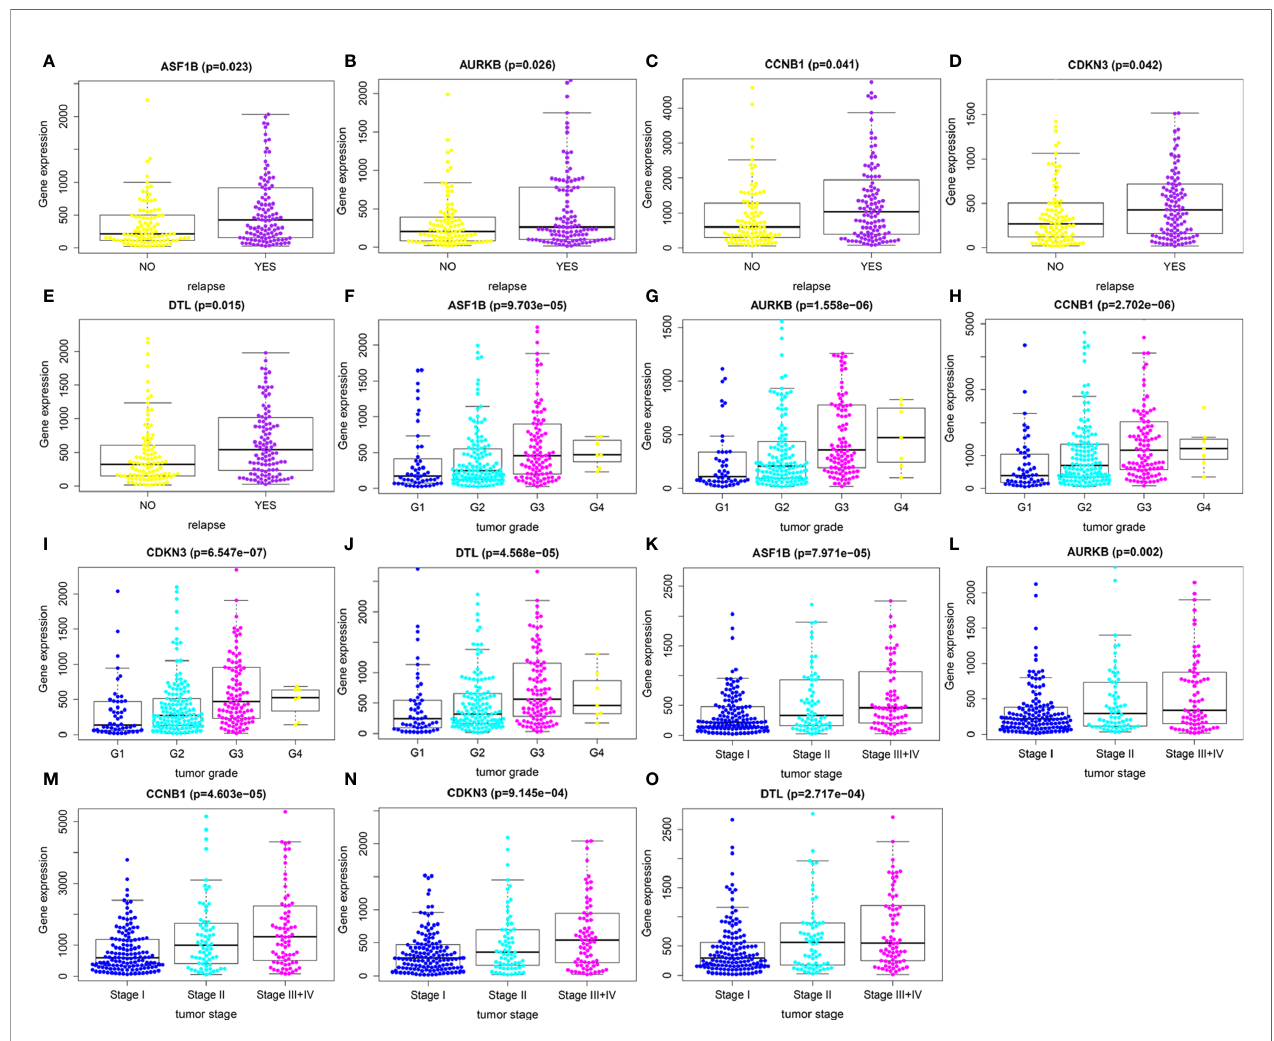
FIGURE 3 | Identi fi cation of relapse-related DEMs. (A – E) The relationships between expression levels of hub genes and HCC recurrence. (F – J) The relationships between expression levels of hub genes and tumor grade. (K – O) The relationships of expression levels of hub genes and tumor